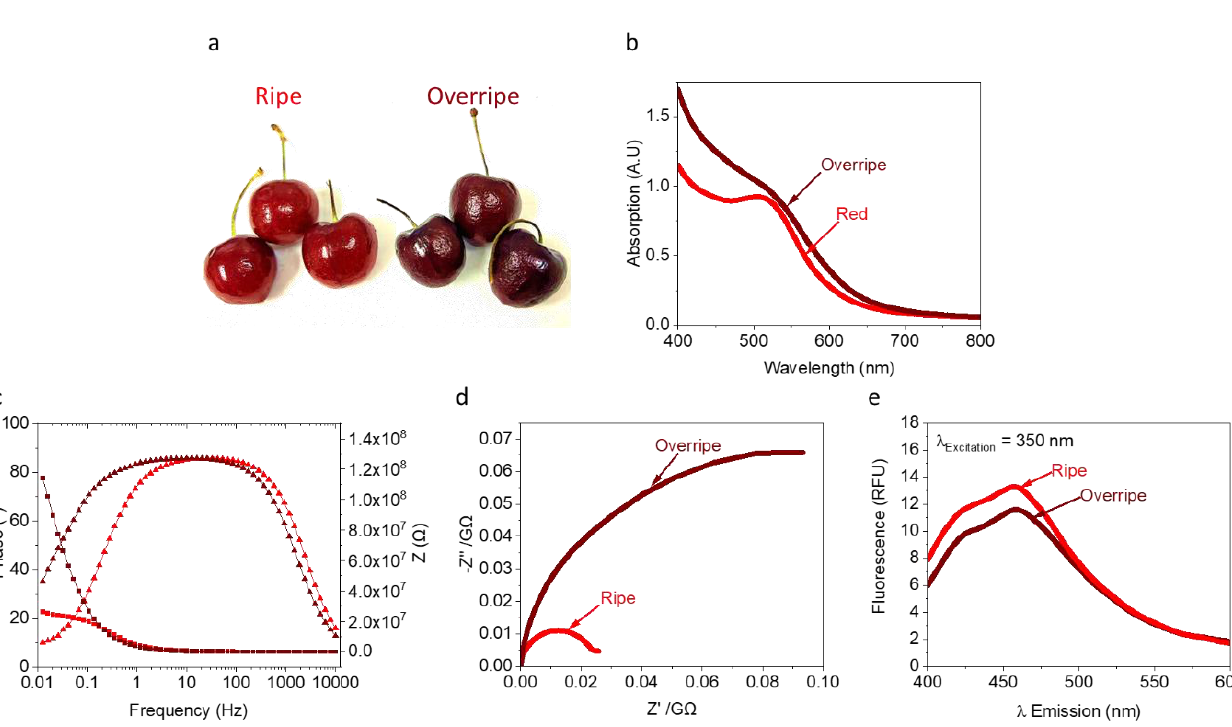
Figure 2. Analysis of the internal electrolyte in ripe, and overripe red cherries. Absorption, EIS, and fluorescence measurements were conducted for the internal solution of ripe and overripe cherries. ( a ) Photograph of ripe ( left ) and overripe ( right ) cherries. ( b ) Absorption spectra of the ripe and overripe cherries’ juices. ( c , d ) EIS of ripe and overripe cherry ( e ) Fluorescence spectra of ripe and overripe cherry juice (λ Excitation = 350 nm, λ Emission = 400 – 600 nm).